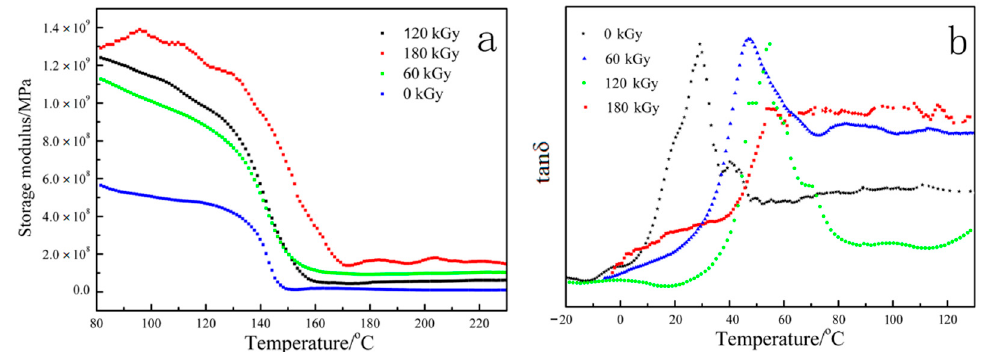
Figure 10. Dynamic mechanical behavior of ETFE treated with various irradiation doses after 336 h aging reaction.